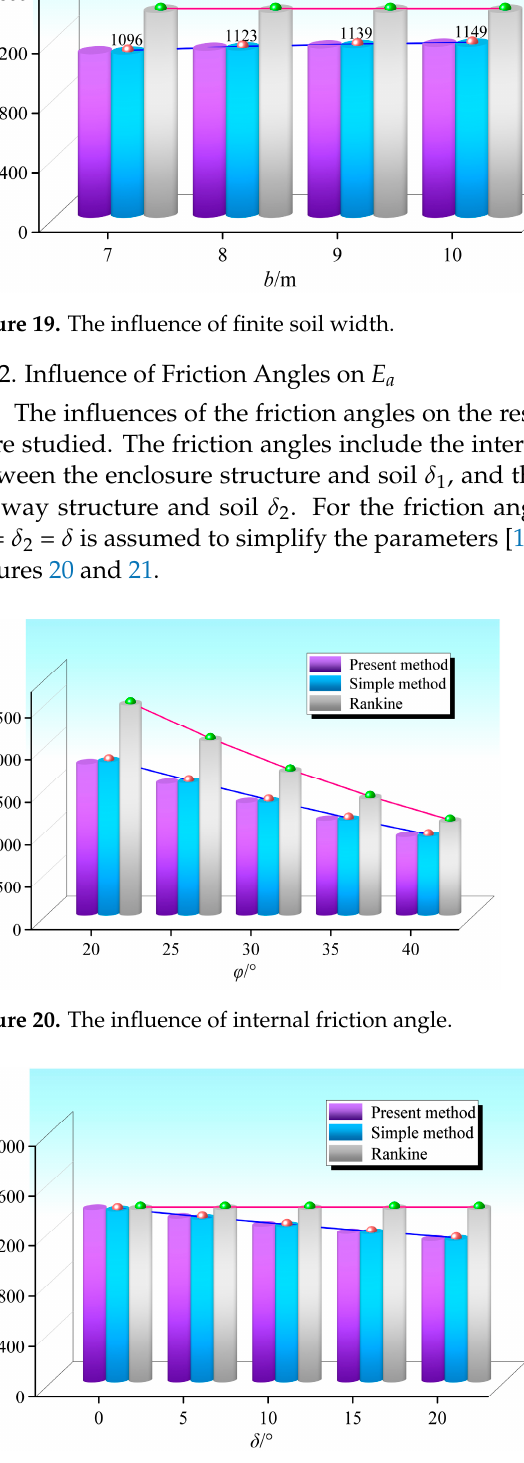
Figure 18. The influence of overlying soil thickness.